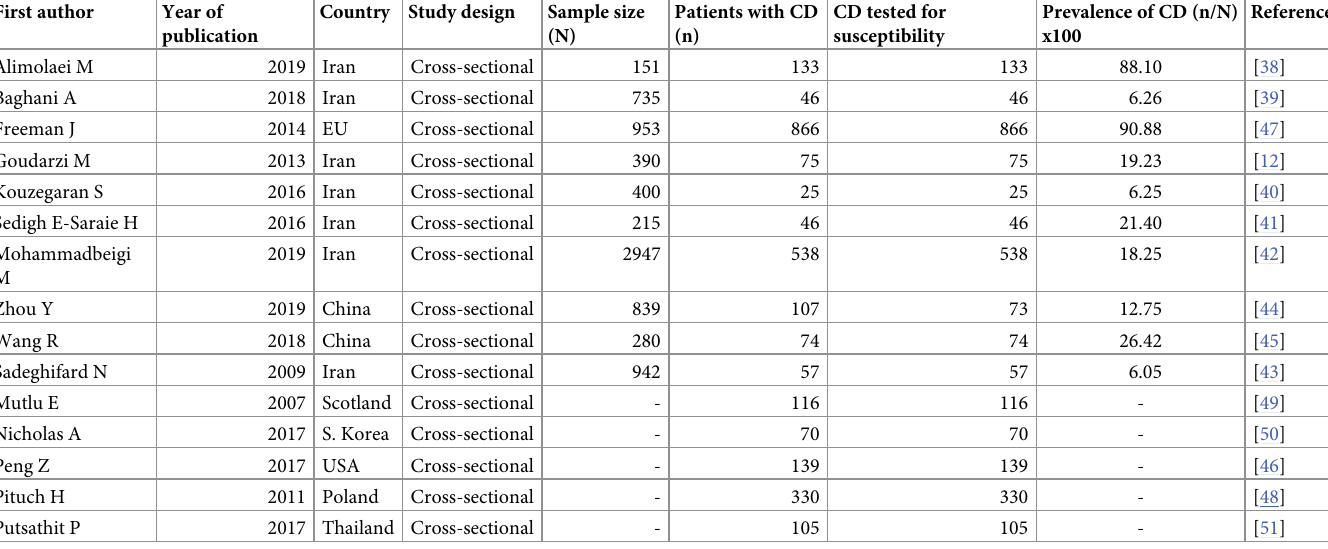
Table 1. The characteristics of included studies for prevalence and antimicrobial susceptibility of C . difficile among hospitalized diarrheal